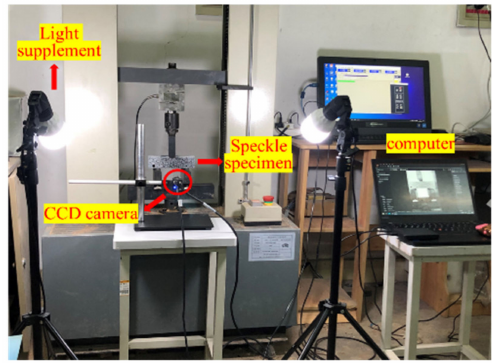
Figure 2. Schematic diagram of DIC test